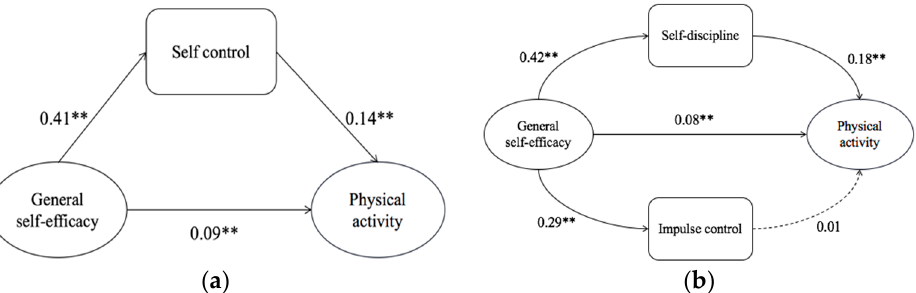
Figure 1. Mediating effect of self-control: ( a ) mediation model; ( b ) parallel mediation model. (** p < 0.01).